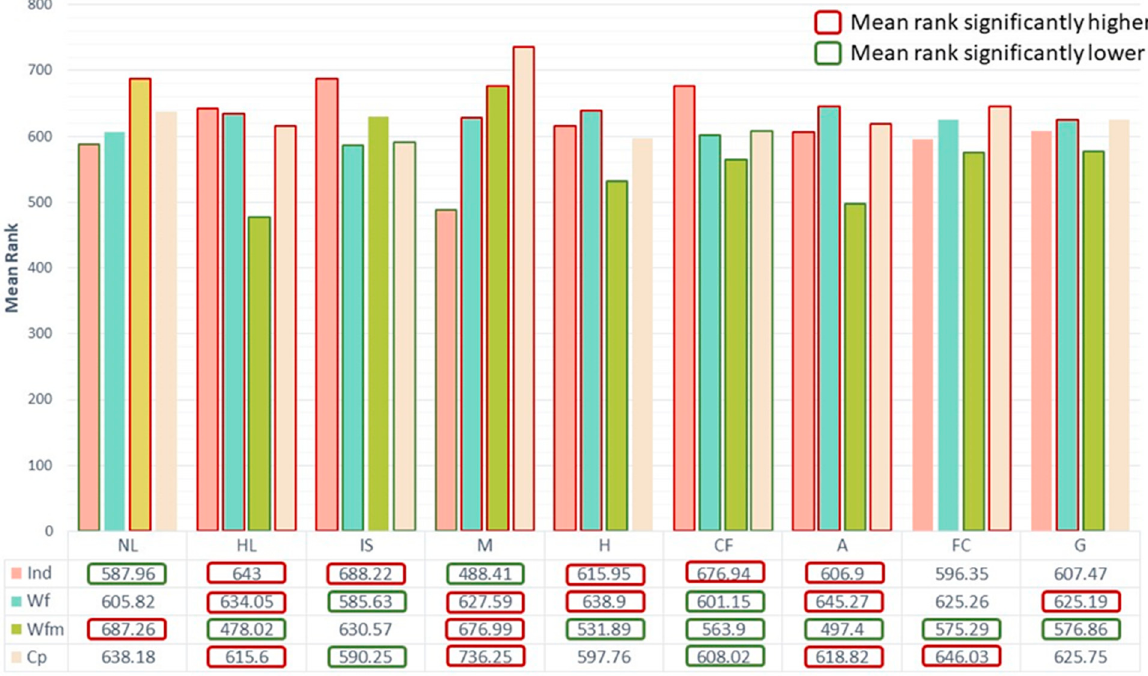
Figure 6. Kruskal-Wallis one-way ANOVA independent sample multiple comparison of travel pattern. Note: NL: natural landscape; HL: human landscape; IS: ice and snow; M: meadow; H: heritage; CF: customs and festivals; A: architecture; FC: folk culture; G: gastronomy; Ind: Individual; Wf: With friends; Wfm: With family members; Cp, Cou- ples.